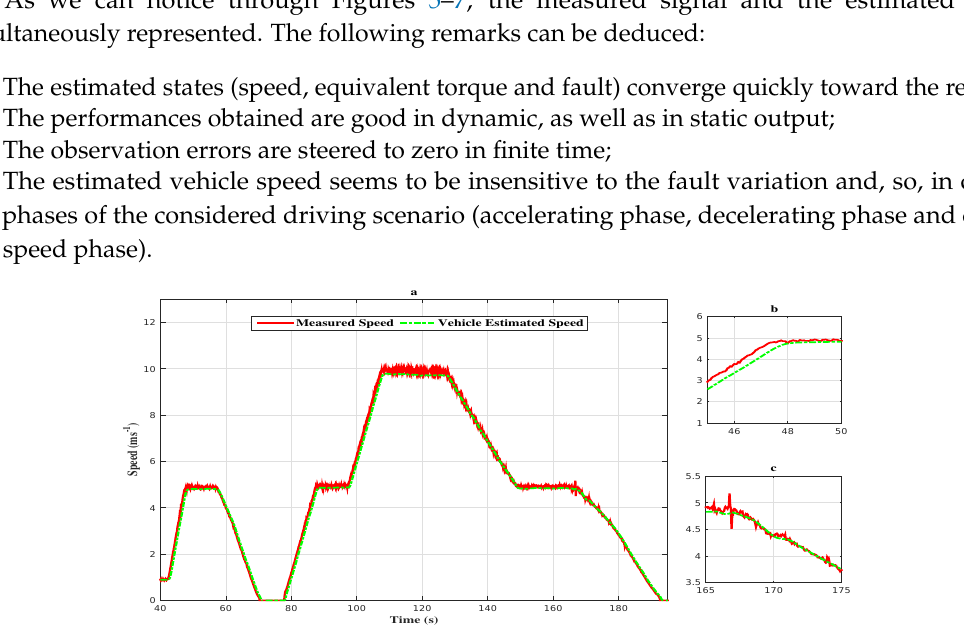
Figure 5. ( a ) Speed profile of the vehicle with the descriptor observer. ( b ) Zoom in at t ∈ [ 45 s,50 s ] . ( c ) Zoom in at t ∈ [ 165 s,175 s ] .